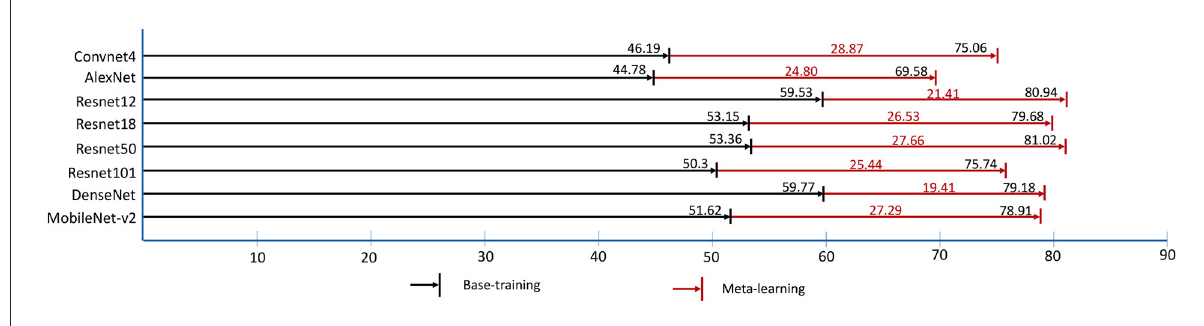
FIGURE6 The best validation accuracy (%) of “1-shot, 5-way” task in base-training and meta-learning. The red digits represent the accuracy lifting ranges (%) of meta-learning.